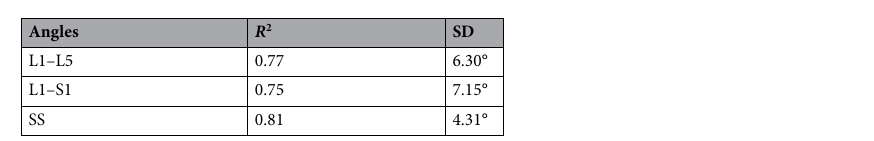
Table 2. Regression analysis comparing the angles calculated from the manually annotated vertebral landmarks (ground truth) and those calculated from the corners predicted by our model.